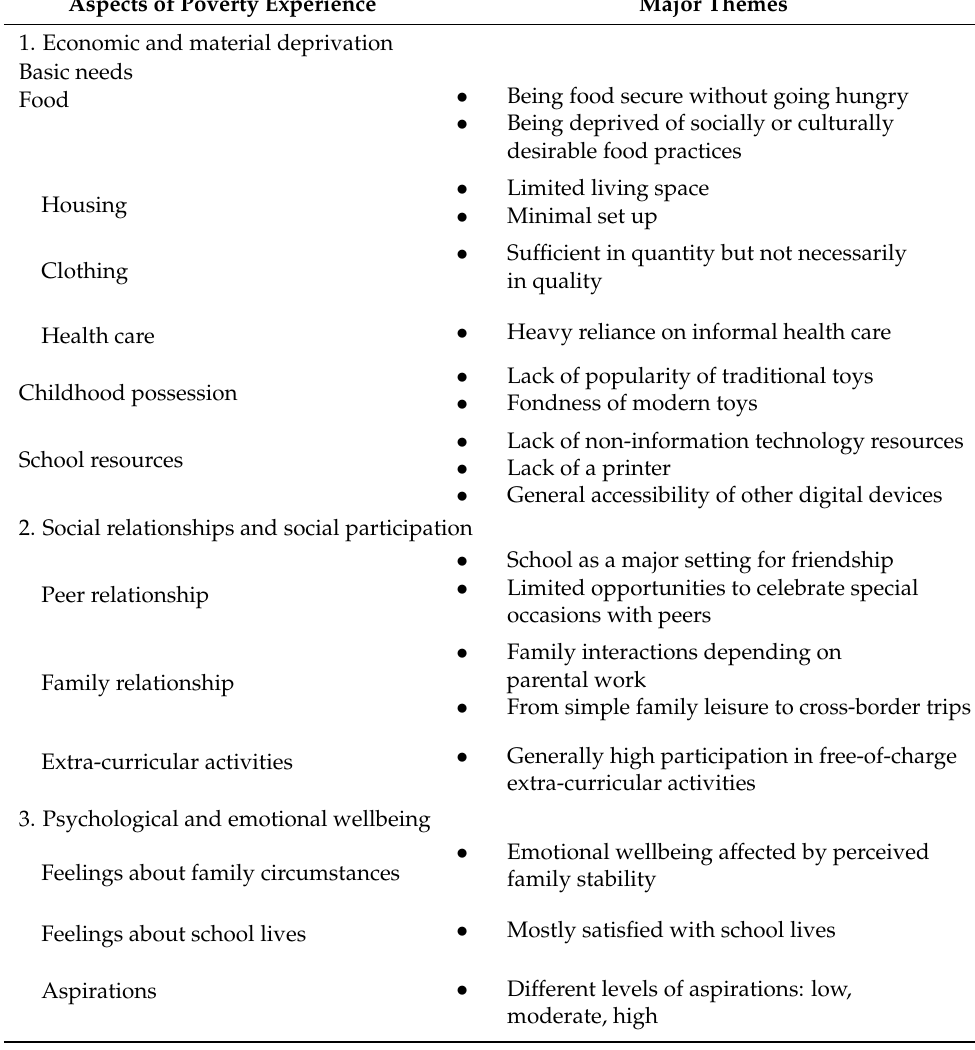
Table 2. A summary of major